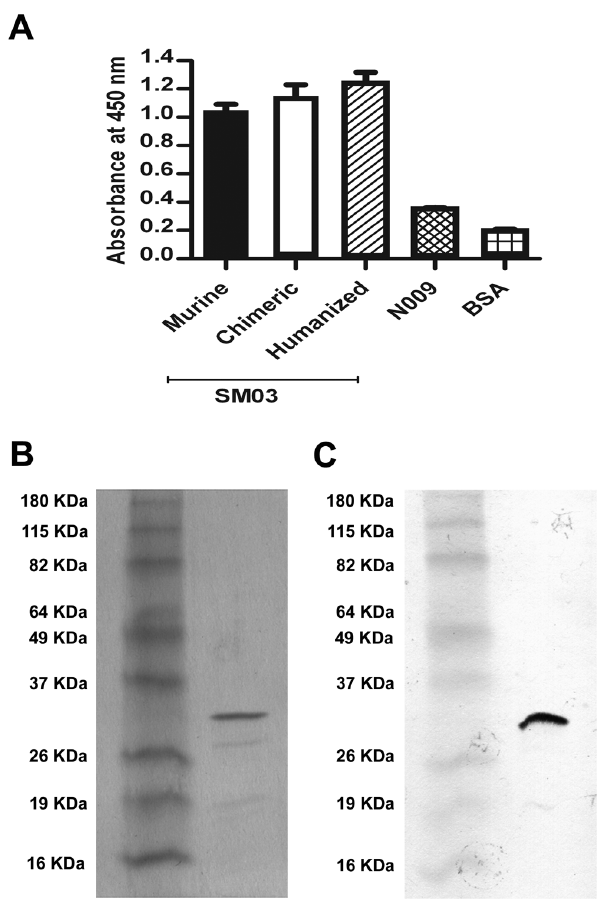
Figure 4. Characterization of anti-idiotype phage clone Hc5. (A) Idiotype binding of phage clone Hc5 was confirmed by its specific binding to immobilized chimera, murine and humanized anti-CD22 (SM03) in phageELISA, but not to negative controls of anti-TNF a (N009) and BSA. Results are expressed as means 6 SEM of duplicates. Expression of anti-Id scFv Hc5 was analyzed by SDS-PAGE (B) and western blotting (C). Bacterial expressed and purified His 6 -tagged scFv Hc5 was electrophoresed in 12% acrylamide gel and stained with Coomassie blue. The ScFv Hc5 was transferred onto nitrocellulose membranes and detected with a mouse anti-His 6 antibody as described in Methods.